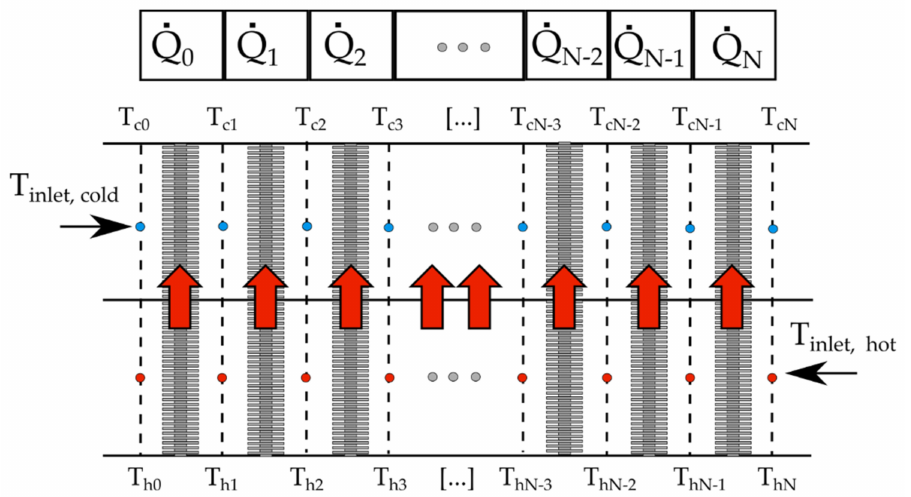
Figure 5. Scheme of the dividing of HPHE into control